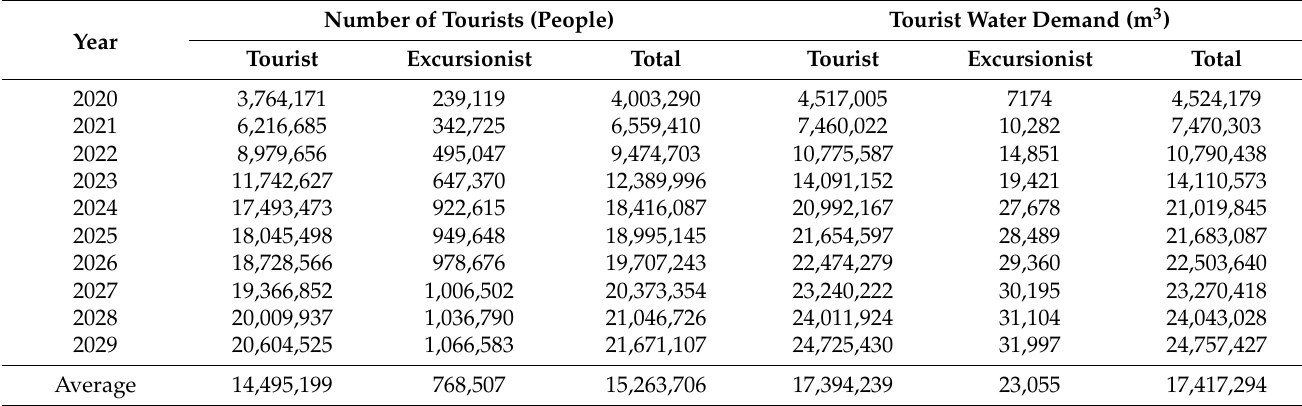
Table 22. The number of tourists and water demand between 2020 and 2029 under new normal conditions.